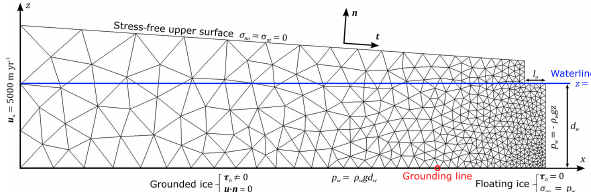
Figure 2. Example mesh and boundary conditions (not to scale). Mesh resolution increases close to the calving front and basal boundaries. Symbols: normal stress σ nn , shear stress σ nt